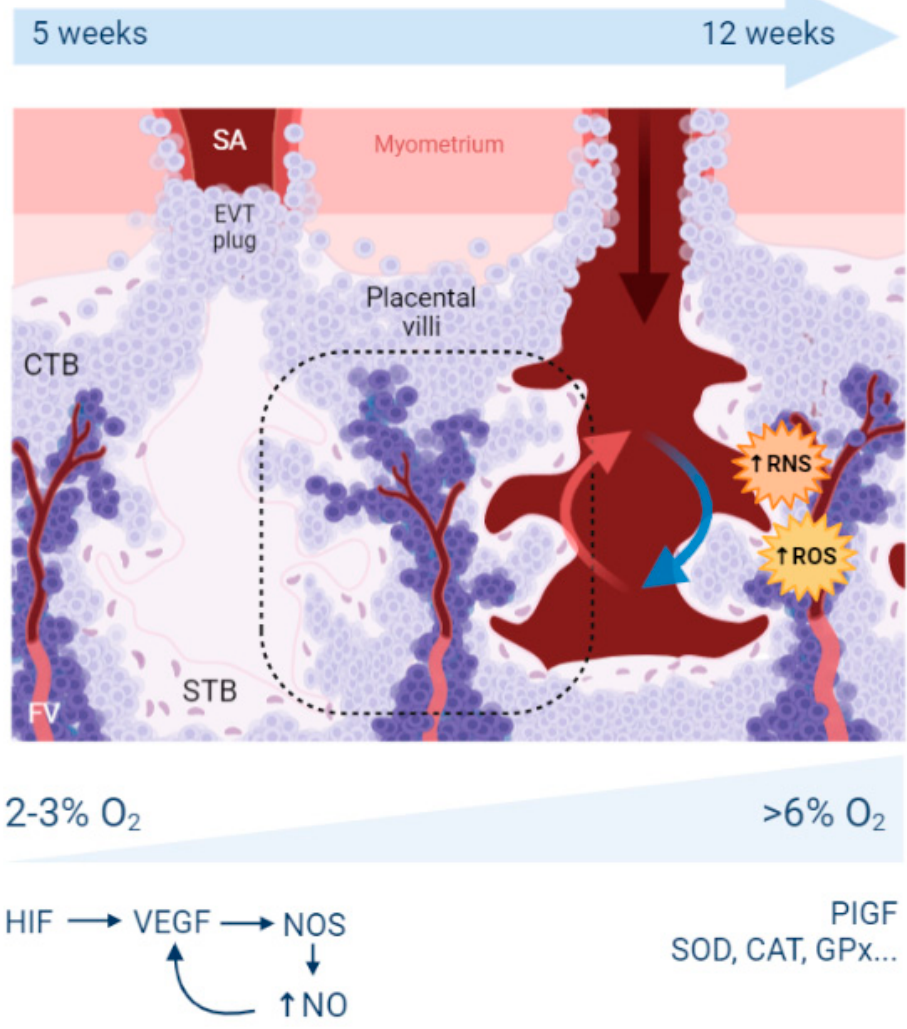
Figure 1. Schematic representation of a placental villous tree during human pregnancy. These tree- like structures are composed of an outermost syncytiotrophoblast (STB) layer in pink, cytotrophoblast (light purple) and fetal stromal cells (dark purple). Fetal capillaries invade these structures to obtain nutrients and exchange gases. Between each placental villous, maternal lacunae are visible, where the maternal spiral arteries potentially deliver the maternal blood. In the early stages of pregnancy, this supply is blocked by extravillous trophoblast plugs, leading to a low oxygen concentration (2–3% O 2 ). Expression of hypoxia-inducible transcription factors (HIF) stimulates the expression of the vascular endothelial growth factor (VEGF), which stimulates the production of nitric oxide (NO). NO stimulates, at the same time, VEGF functions as a pro-angiogenic molecule. Once these plugs are removed around week 12 of pregnancy, the maternal blood bathes the lacunae, allowing the interchange of nutrients and gases between the mother and the foetus. This highly oxygenated blood increases the oxygen tension to normoxic levels (6–8% O 2 in the tissue context), increasing the STB mitochondrial activity and thus, the release of reactive oxygen species (ROS) and reactive nitrogen species (RNS). Increased OS induces the expression of antioxidants such as superoxide dismutase (SOD), catalase (CAT), glutathione peroxidase (GPx). Oxygen tension stimulates the placental inducible growth factor (PIGF) implicated expression in endothelial growth and angiogenesis.